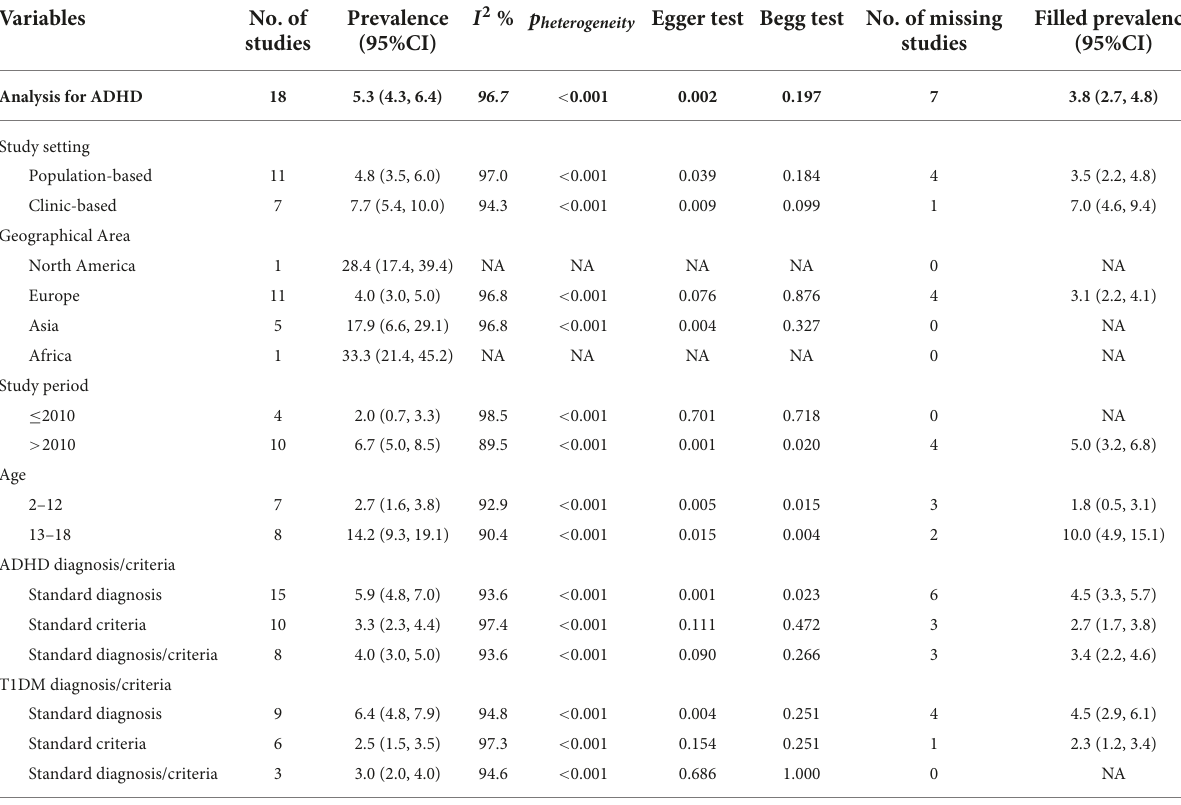
TABLE 2 ADHD in T1DM populations using random-effects meta-analysis and subgroup